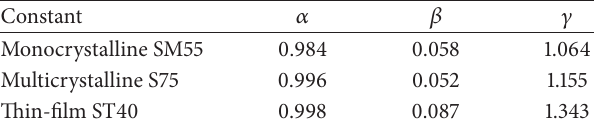
Table 2: Constants estimation for PV